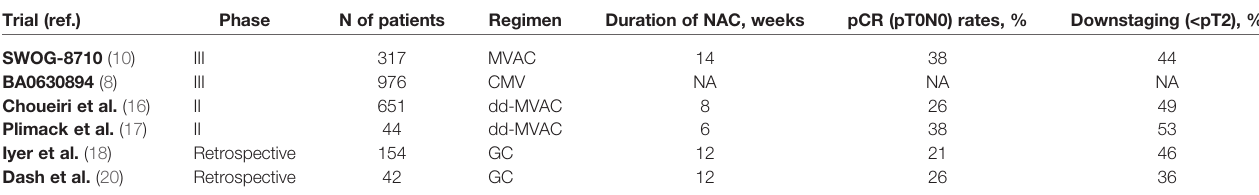
TABLE 1 | Main clinical trials of neoadjuvant cisplatin-based chemotherapy for MIBC. Trial